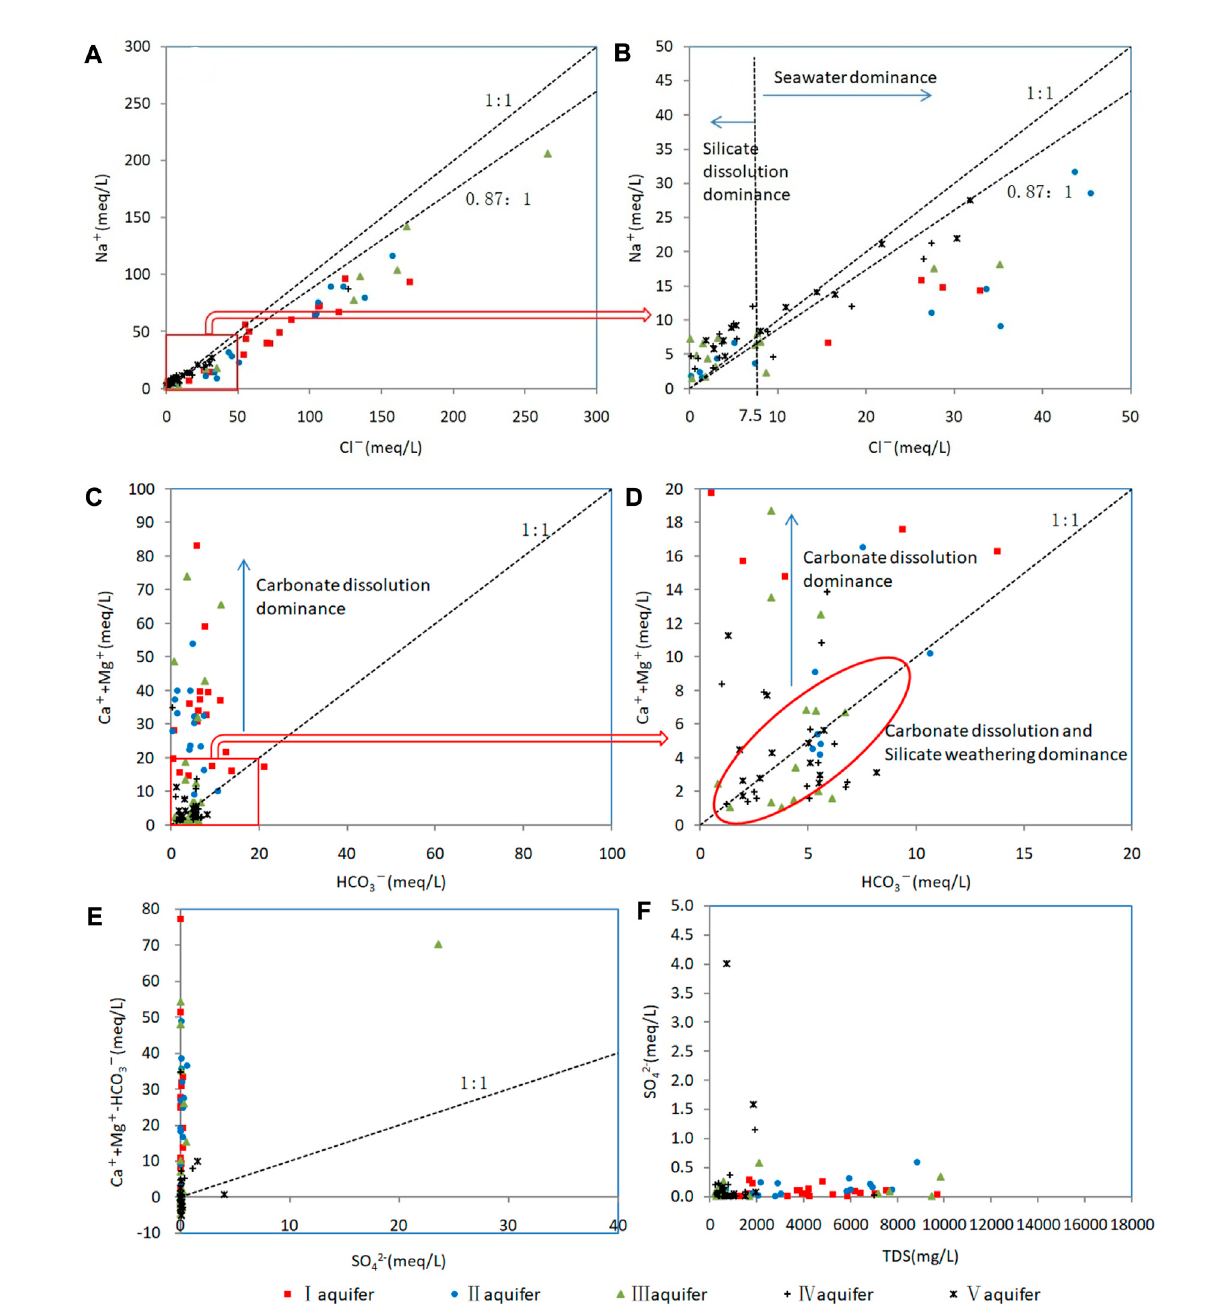
FIGURE 7 Relationships between ion contents of con fi ned groundwater samples. (A) Relationship between Na + and Cl − for all samples. (B) Relationship between Na + and Cl − for samples with Na + and Cl − concentration of < 50 meq L − 1 . (C) Relationship between (Mg 2+ +Ca 2+ ) and HCO 3 − for all samples. (D) Relationship between (Mg 2+ +Ca 2+ ) and HCO 3 − for samples with (Mg 2+ +Ca 2+ ) and HCO 3 − concentration of < 20 meq L − 1 . (E) Relationship between (Mg 2+ +Ca 2+ – HCO 3 − ) and SO 4 2 − for all samples. (F) Relationship between SO 4 2 − and TDS for all